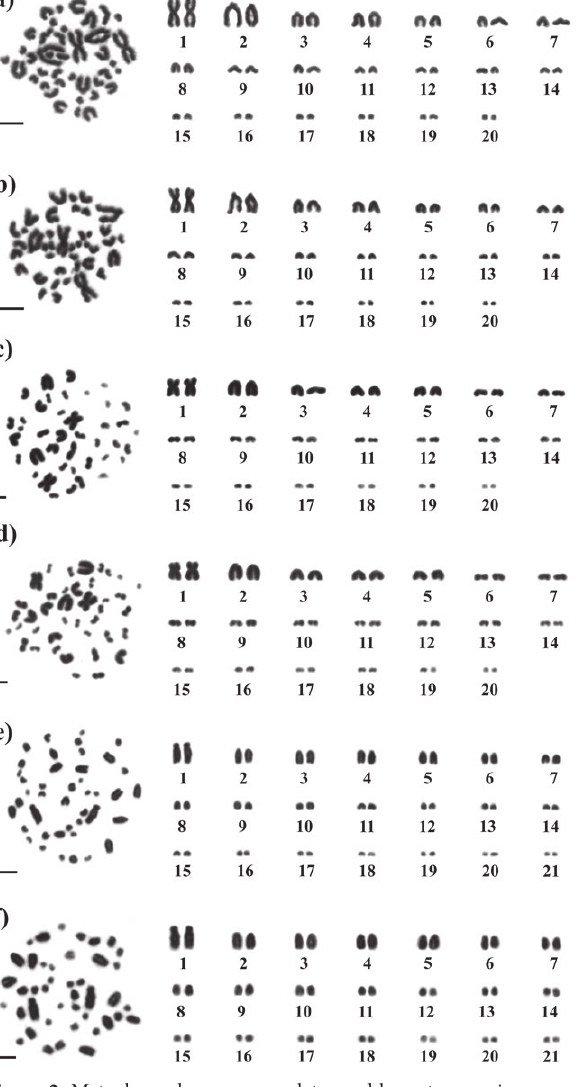
Figure 2. Metaphase chromosome plates and karyotypes using con- ventional Giemsa’s staining of male (a) and female (b) D. hangsee- som (2n=40); male (c) and female (d) D. siamensis (2n=40); and male (e) and female (f) D. melanostictus (2n=42). Scale bars indi- cate 10 micrometers.